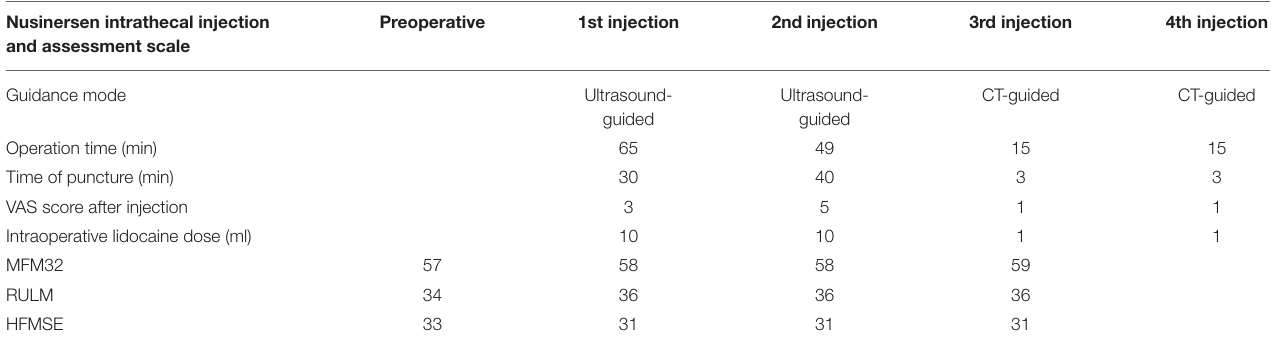
TABLE 2 | Clinical and motor function evaluation with Nusinersen intrathecal injection. Nusinersen intrathecal injection Preoperative 1st injection 2nd injection 3rd injection 4th and assessment scale